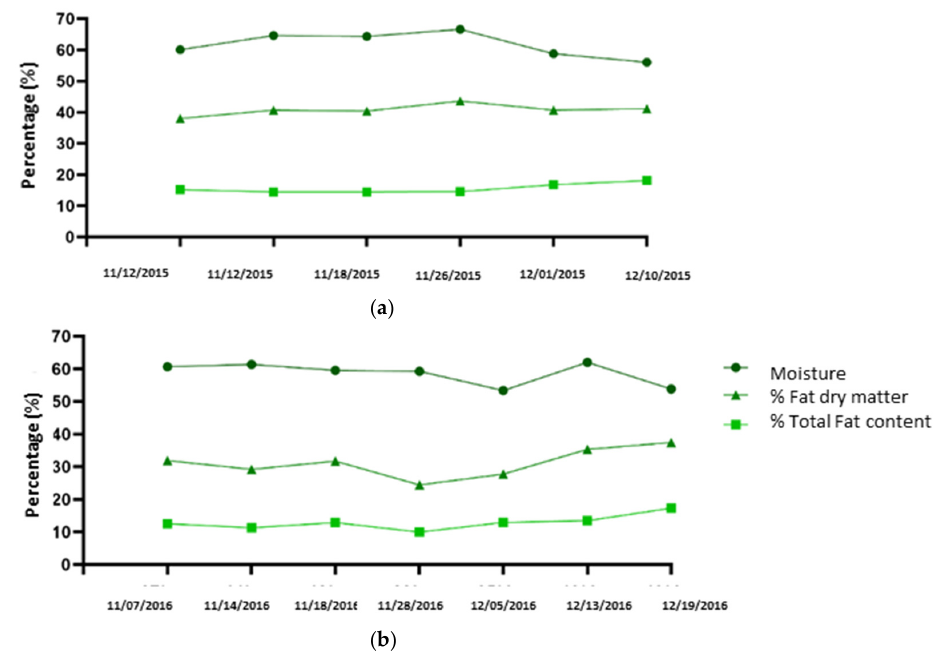
Figure 1. Evolution of fat content (%), moisture (%) and fat content in dry matter (%) in olives of the ‘Madural’ variety ( a ) 2015/2016 season ( b ) 2016/2017 season.